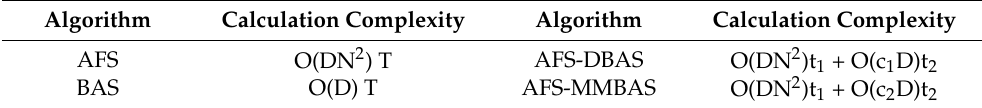
Table 3. Algorithm complexity.